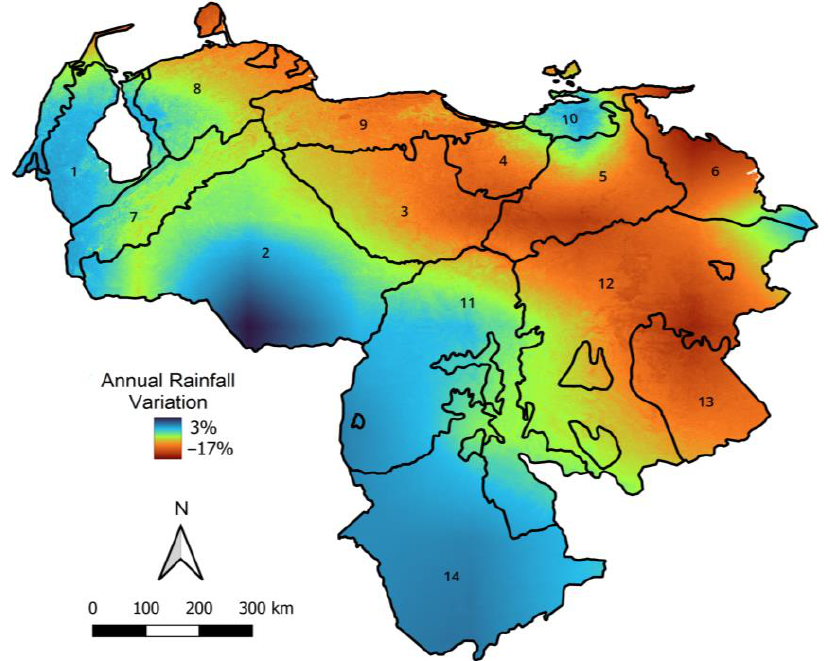
Figure 6. Map of projected changes in annual mean precipitation (mm) between 1970–2000 and 2041–2060 in Venezuela, with the boundaries of the physiographic regions numbered as in Table 4.